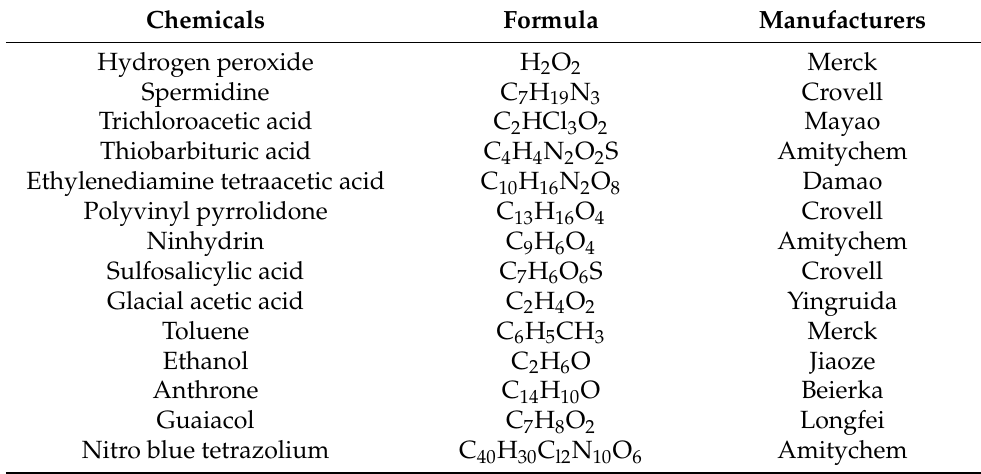
Table A1. List of primary chemicals used in this